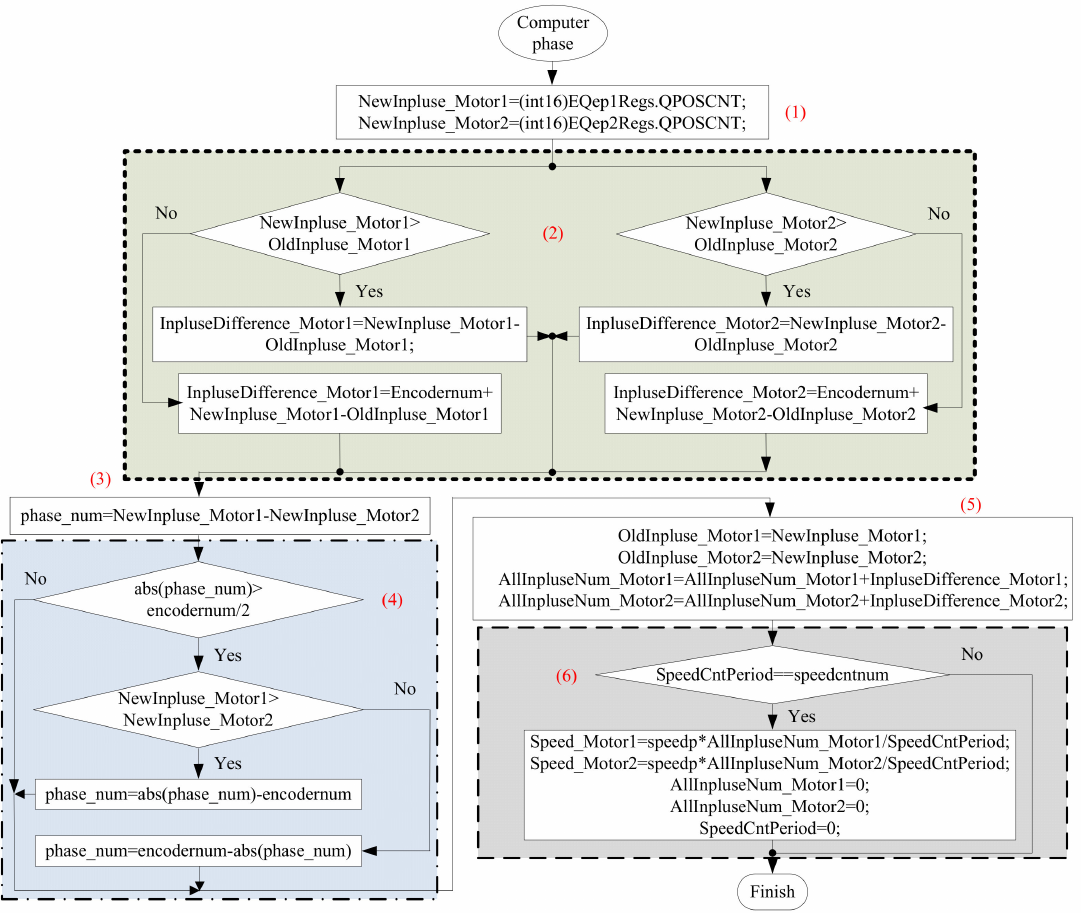
Figure 5. Calculating flow chart of the velocity and the phase